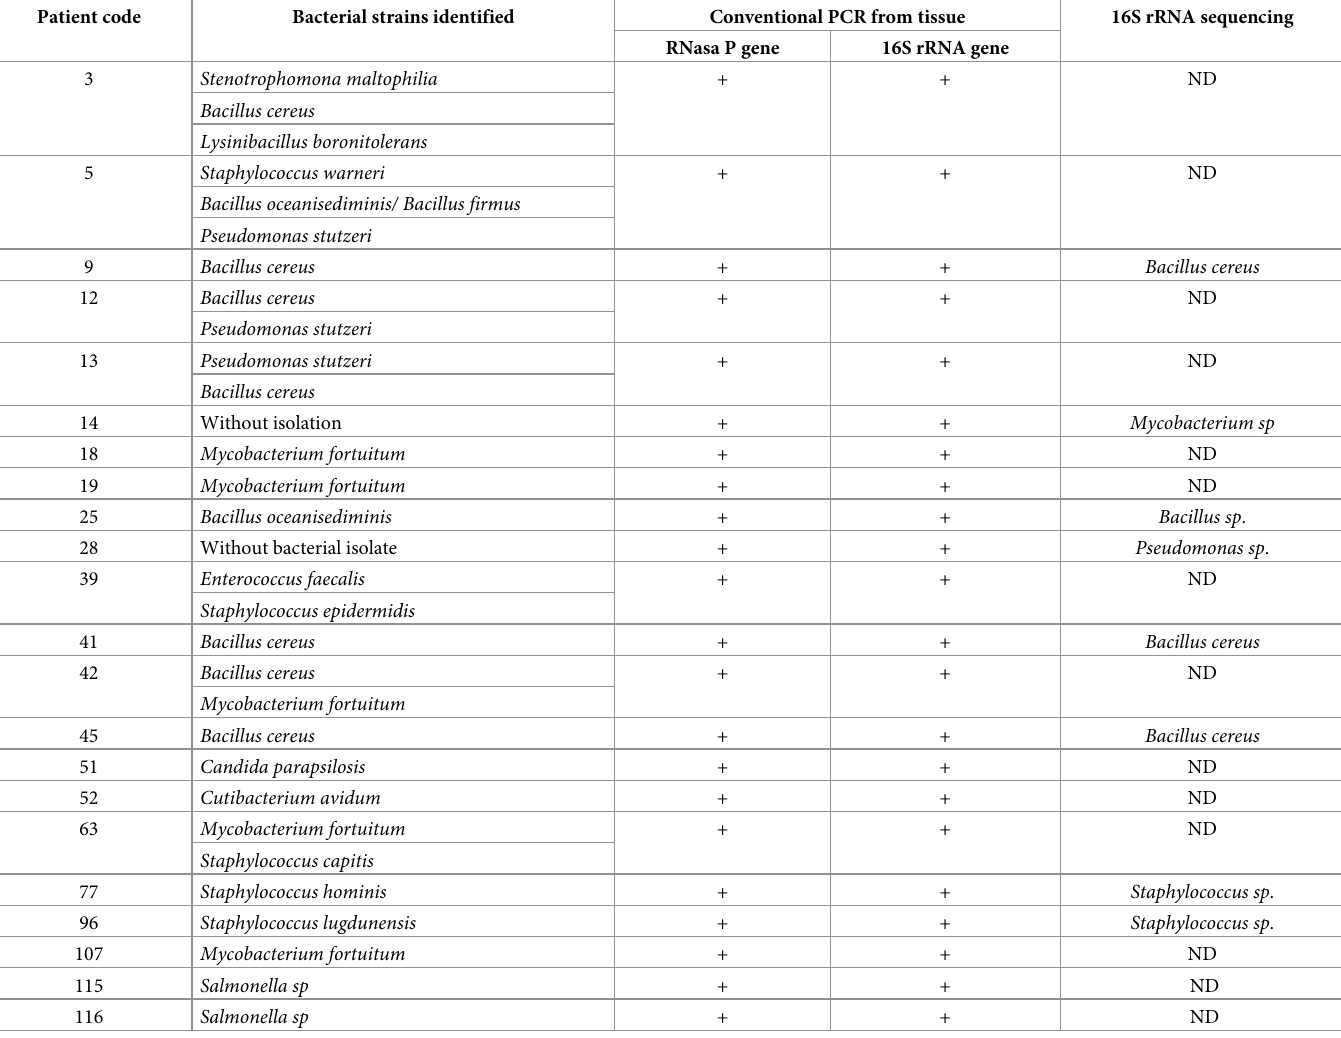
Table 1. Microbiological identification by culture and molecular tests in tissue samples from patients. Patient